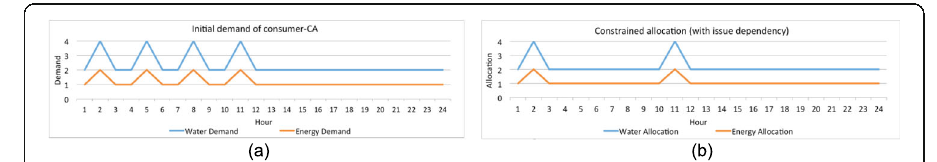
Fig. 10 Multi resource coordination with issue dependency. a Initial resource demand of cosumer-CA.